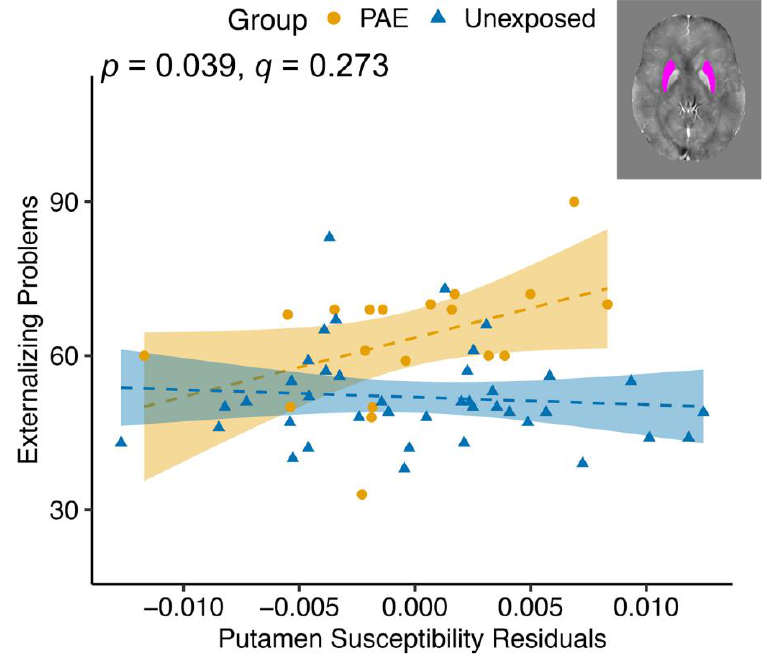
Figure 5. Group–susceptibility interactions in the putamen show that susceptibility is more positively associated with Externalizing Problems in youth with PAE compared to unexposed youth, though relationships were not significant within each group. Susceptibility values are corrected for age and gender. p value indicates the group–susceptibility association. Dashed lines indicate non-significant associations within a group.